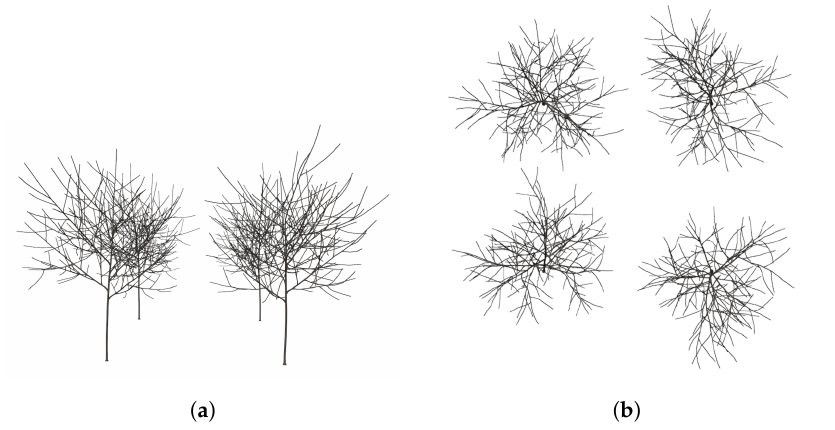
Figure 17. Group of 4 trees growing at 2 m distance. ( a ) Side view of 4 trees growing at 2 m distance; ( b ) Top view of 4 trees growing at 2 m distance.